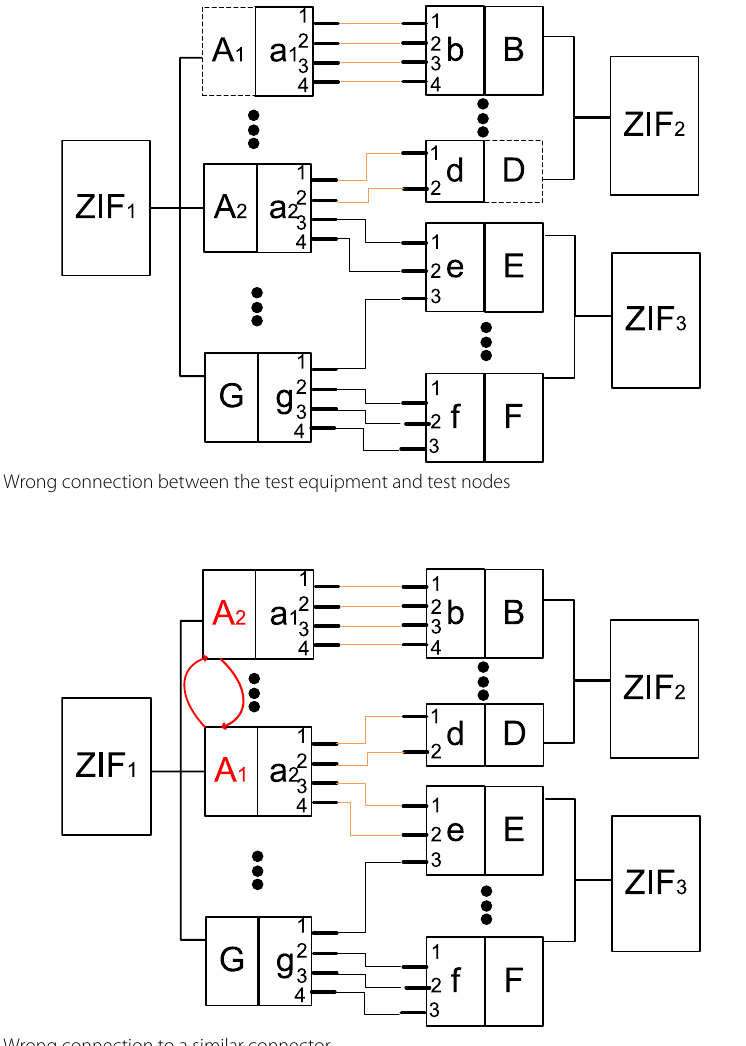
Fig. 9 Wrong connection to a similar